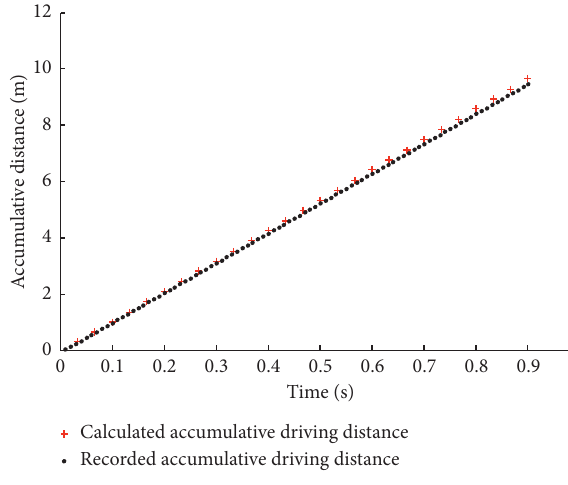
Figure 11: Compared analysis of S and S